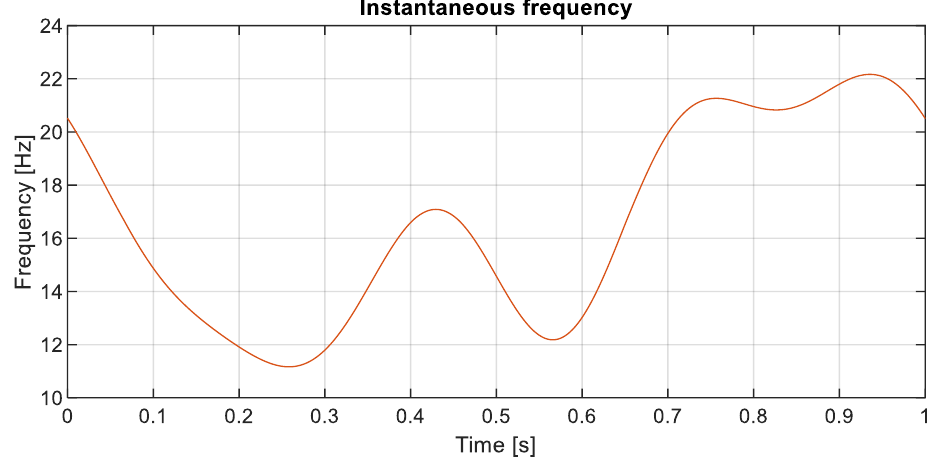
Figure 9. Instantaneous frequency profile simulating machine operational speed.